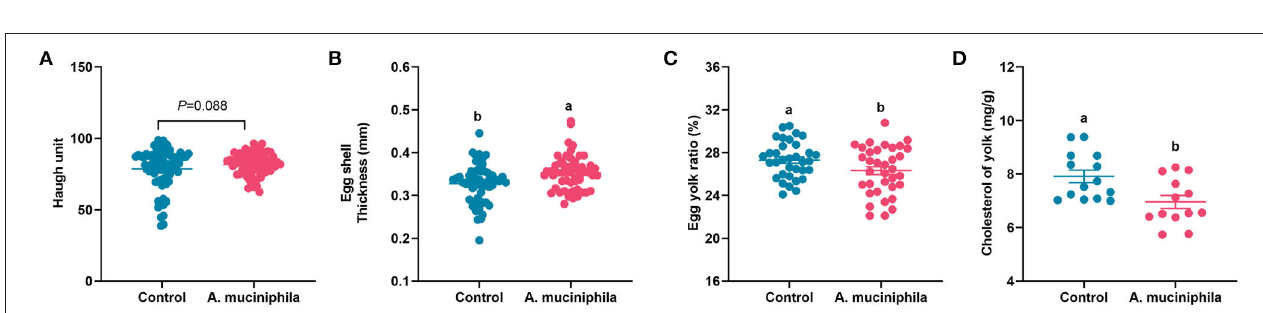
FIGURE 7 | Akkermansia muciniphila improved egg quality in aged laying hens. (A) Haugh unit ( n = 63). (B) Eggshell thickness (mm) ( n = 63). (C) Egg yolk ratio (%) ( n = 63). (D) Cholesterol content in the yolk (mg/g) ( n = 14). Different letters indicate significant differences at p <